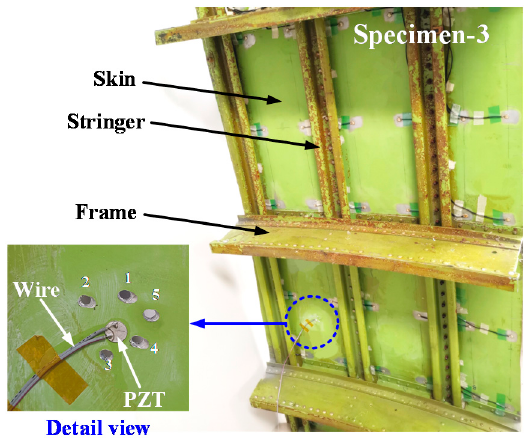
7 Figure 3. Simulated damage severity development by adding drilled holes on specimen-2: ( a ) distribution of seven drilled holes, ( b ) experimentally fabricated specimen with seven drilled holes. 3.2. Experiment on the Real Aircraft Fuselage (Specimen-3) To demonstrate the effectiveness of DCMI methodology in practical and engineering issues, a part of the fuselage was selected to study the damage growth on a complex structure. The specimen of fuselage used in the experiment is shown in Figure 4, where the stiffened structures on the internal surface can be clearly observed. What should be pointed out is that it is more difficult to manually drill holes on the large surface than on the small aluminum plate, thus, there are inevitable deviations